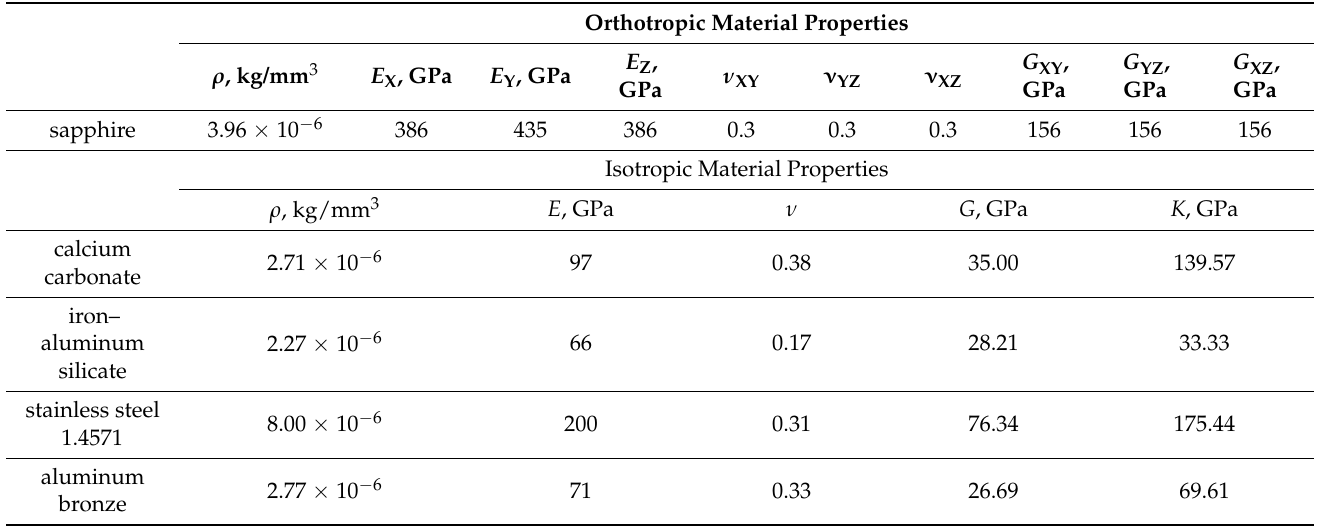
Table 2. Mechanical properties of sapphire (Al 2 O 3 ), calcium carbonate (CaCO 3 ), iron–aluminum silicate (Fe 3 Al 2 [SiO 4 ] 3 ), stainless steel, and aluminum bronze used for modeling. Orthotropic Material Properties